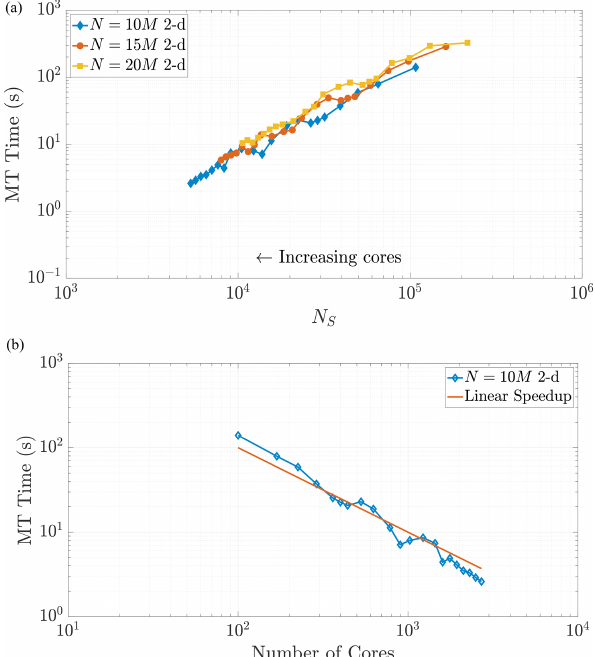
Figure 7. Varying the total particle number N directly influences the value of N S , as the rightmost side of Eq. (23) reflects. Simu- lations across these different values of N in 2-D exhibit common behavior with respect to MT run time as N S decreases, as shown in (a) . Panel (b) shows the strong scaling behavior for the 10M par- ticle simulation for comparison to a common scaling metric. Axis limits are chosen for comparison with Fig. 10a.